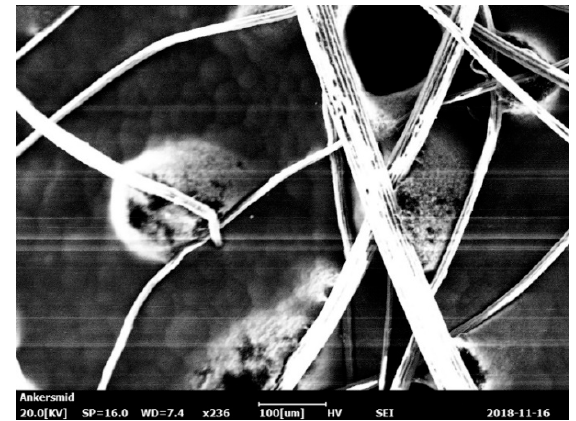
Figure 4. An SEM image of peat fibers (scale 236×) with a fiber thickness of 50 μ m (the appearance of bubbles in the background is the result of evaporation of the glue on the heated surface).